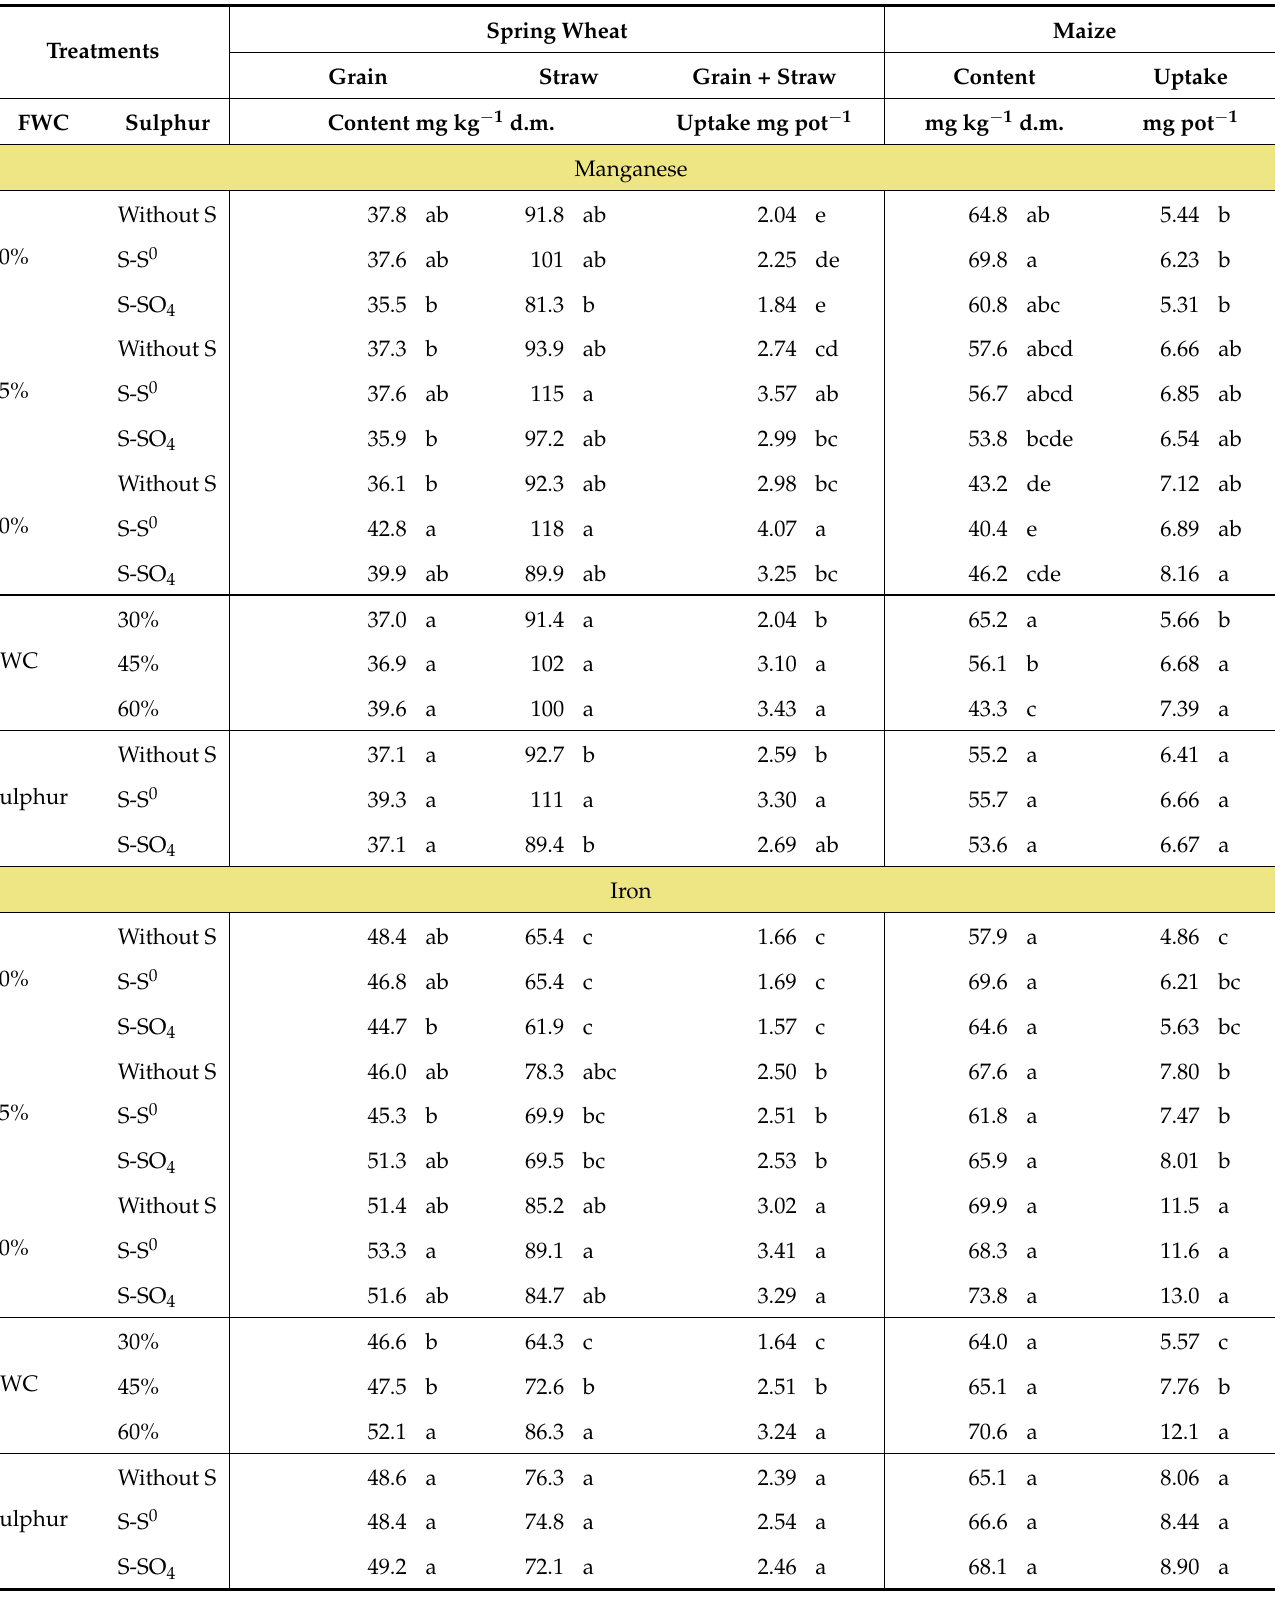
Table 6. Manganese and iron content and uptake in cultivated plants. Values indicated by the same letter are not significantly different ( α =